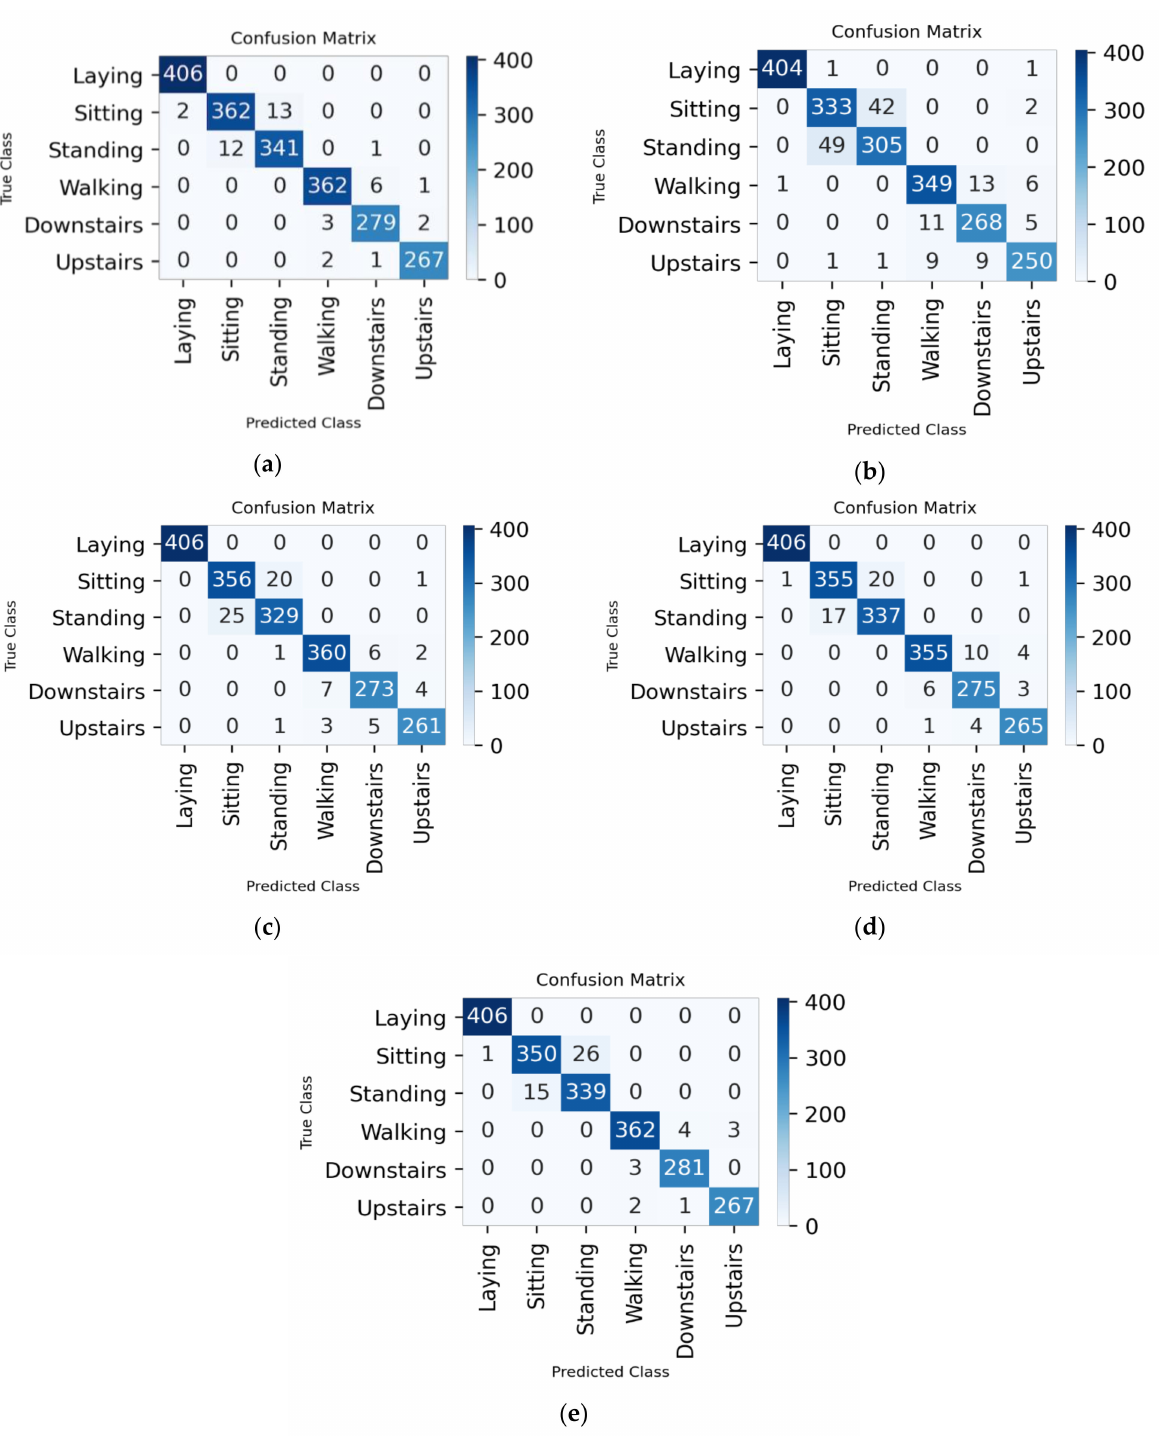
Figure A1. Confusion matrix for 70–10–20% split ratio: ( a ) all the features; ( b ) 48 features; ( c ) 92 features; ( d ) 138 features; and ( e ) 164